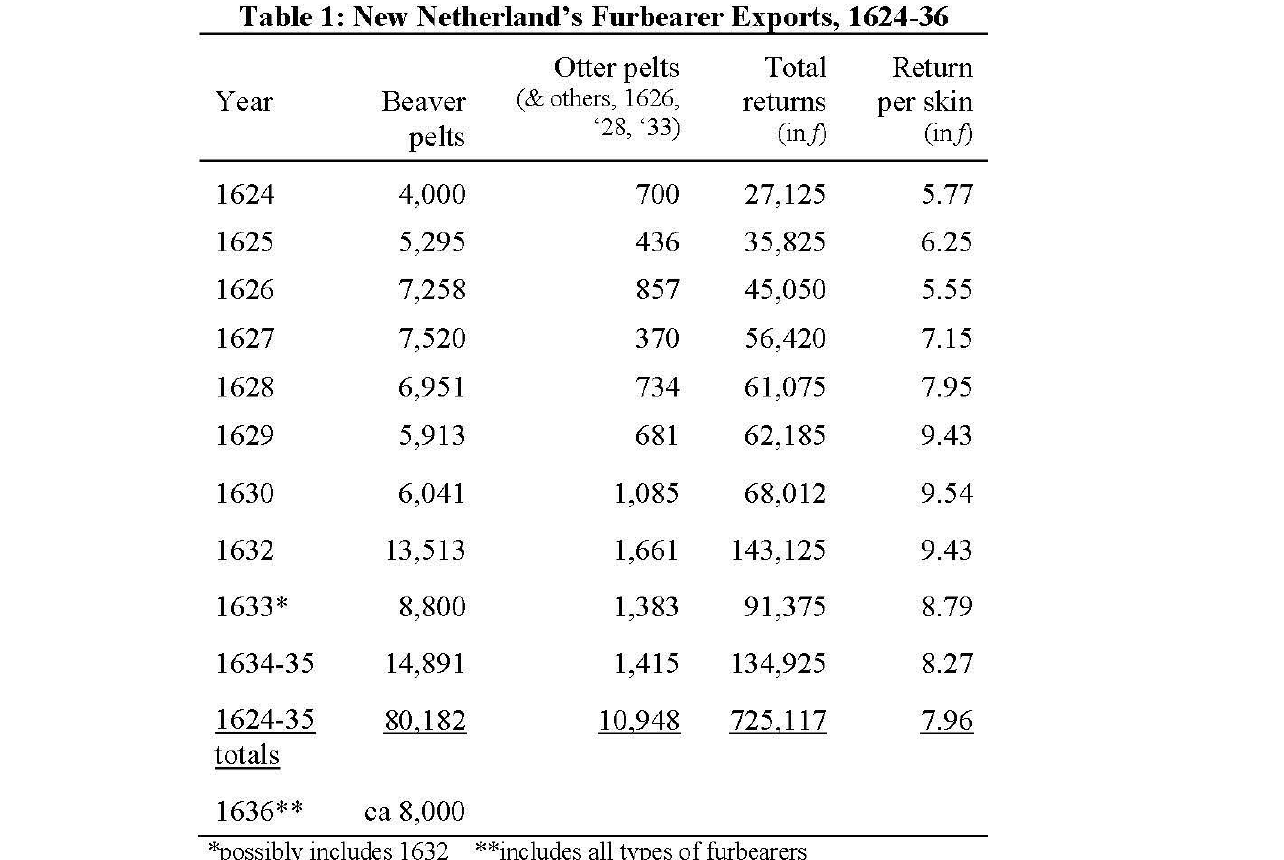
Table 1: New Netherland's Furbearer Exf!orls,